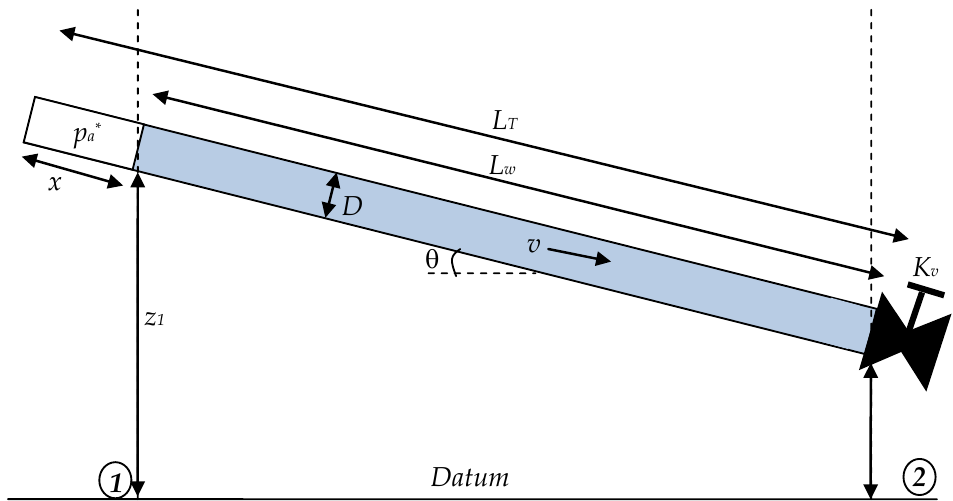
Figure 1. Schematics of a draining process in a single pipeline with an entrapped air pocket.